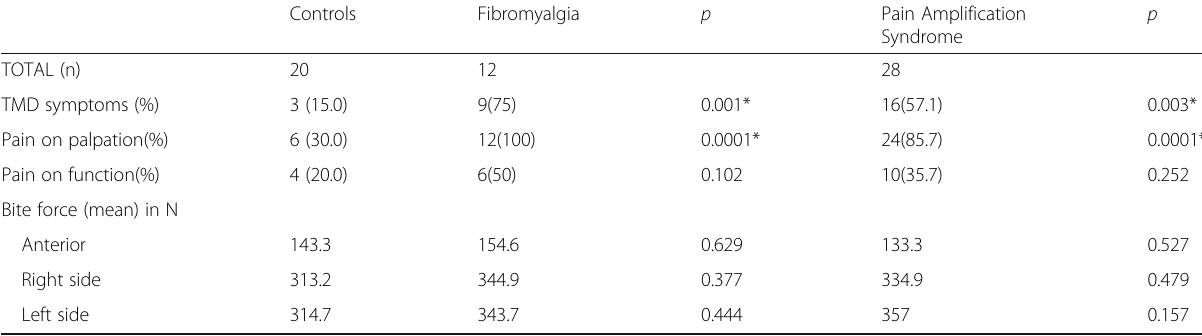
Table 3 Temporomandibular Disorders (TMD) symptoms and signs and bite force measurement of the two patients groups and